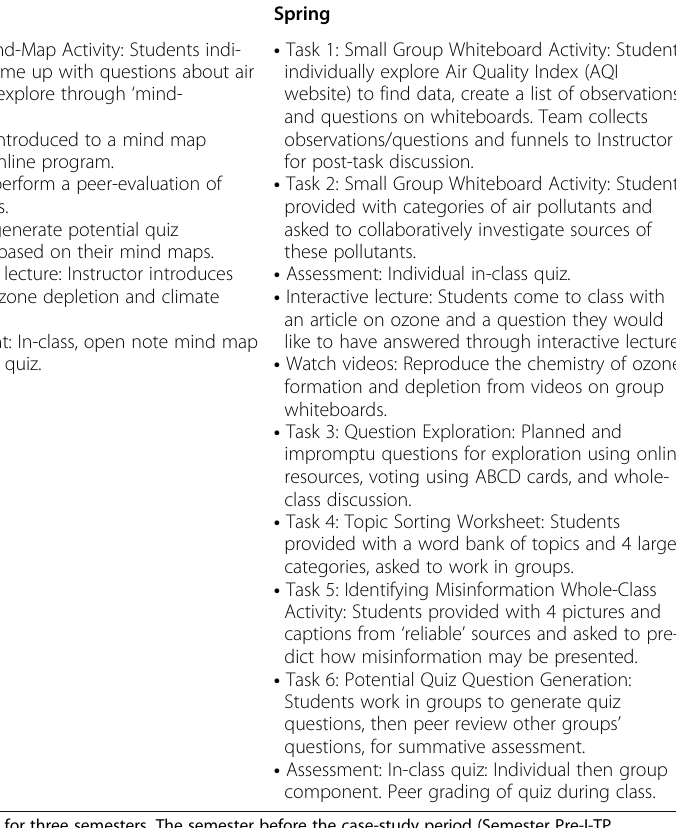
Table 2 Evolving instructional task structure for the Air Quality Unit Course: Fundamentals of Environmental Science and Sustainability Content Topic: The Atmosphere: Air Quality and Pollution Semester Pre-I-TP